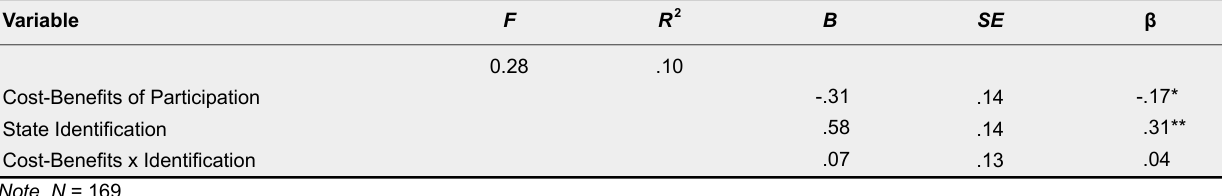
Study 1: Hierarchical Regression for Willingness to Participate in Public